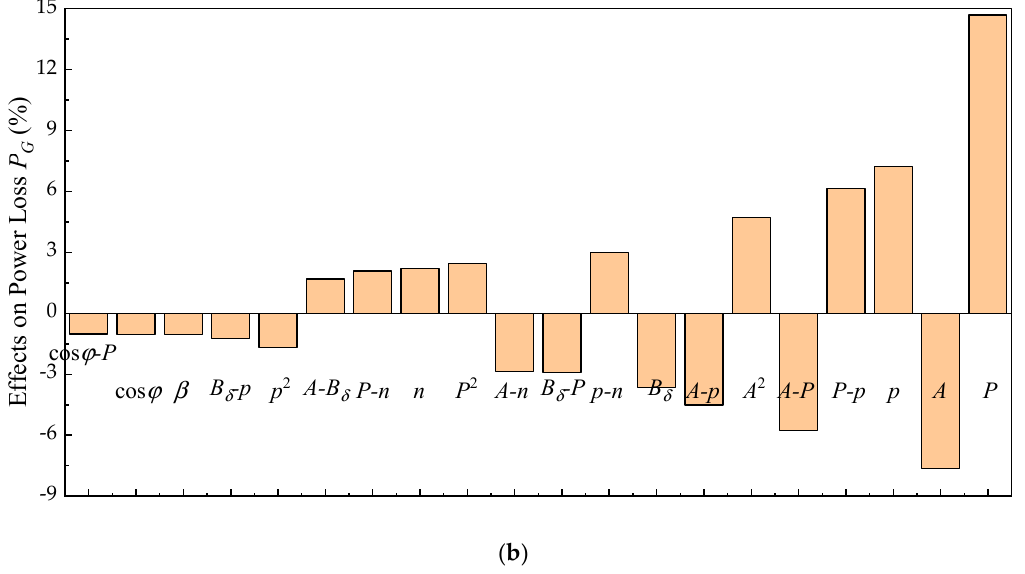
Figure 8. The top 20 contribution plots: (a) contributions to the weight; (b) contributions to the power loss. x - y means the coupling between variable x and variable y .